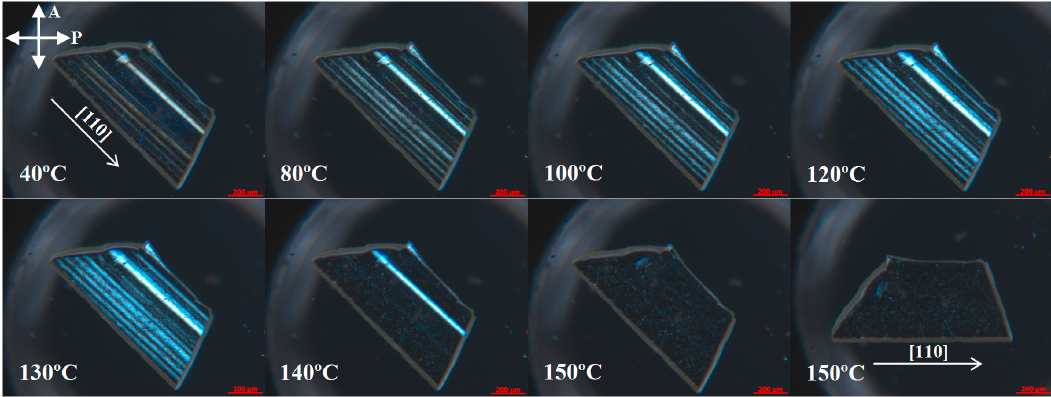
Figure 5. Temperature dependence of [111]-oriented plates of PLN-0.07PT crystal under a crossed polarized light microscope.